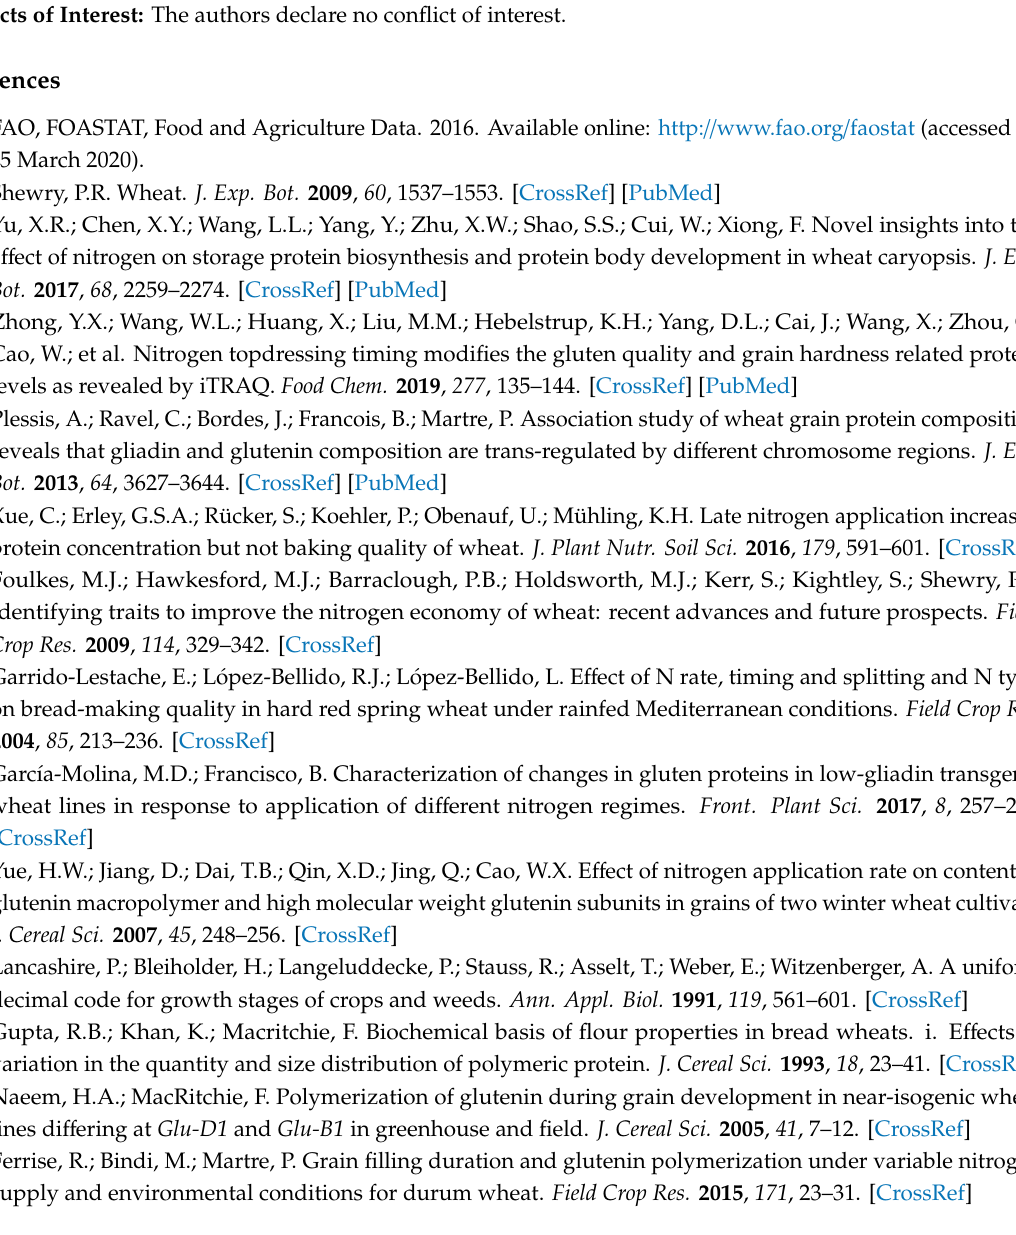
RP-HPLC. Figure S2: Plant nitrogen (N) uptake, recovery e ffi ciency, nitrogen use e ffi ciency (NUE)–total protein yield, NUE–GMP yield, grain yield, and NUE–grain yield of the wheat lines with Glu-1Dd and Glu-1Da under di ff erent N management strategies. Same letter in the di ff erent columns for each material indicate no significant di ff erence ( p > 0.05). Data are present as mean of two years. Table S1: Pearson correlation coe ffi cients